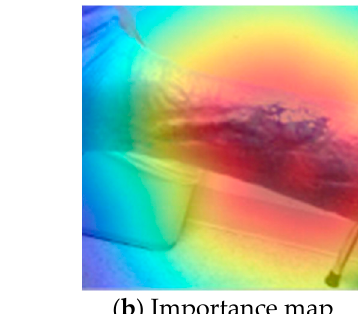
Figure 10. The probabilities of wound types: Lymphovascular: 87.8%, diabetic: 7.4%, pressure in- jury: 4.8%, surgical: 7.3% (Lymphovascular).